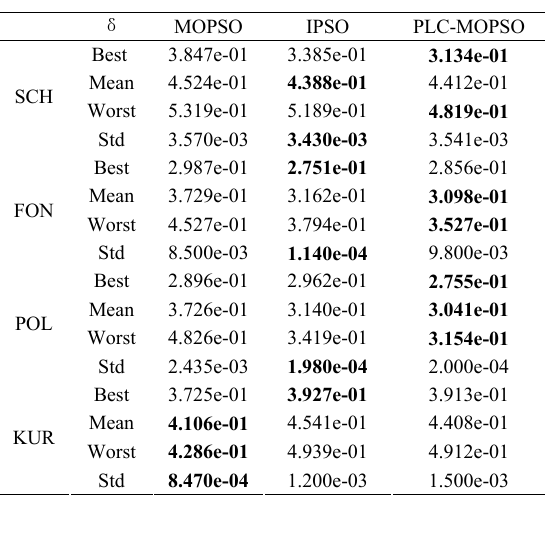
Table 5 Results of the diversity metric for test problems MOPSO and IPSO. In order to clearly visualize the